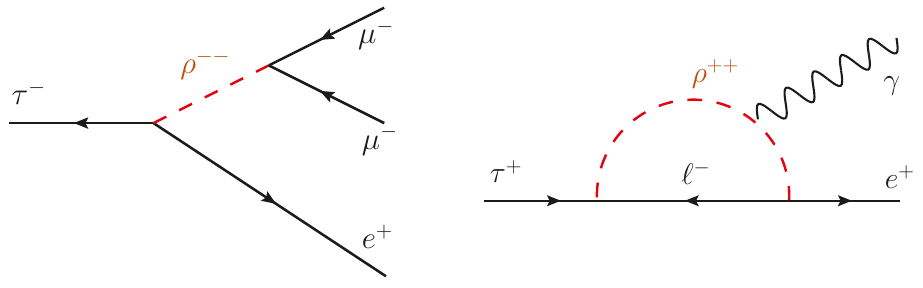
Figure 3 . Feynman diagrams in Class 1 for lepton (cid:13)avour violating processes mediated by (cid:26) (cid:6)(cid:6) at tree-level (Left: (cid:28) (cid:0) e + (cid:22) (cid:0) (cid:22) (cid:0) ) and loop-level (Right: (cid:22) + e + (cid:13) ). ! ! H(cid:31)‘ R (for an SU(2) L doublet (cid:31) ). In addition, this Z 2 symmetry would stabilize the lightest Z 2 -odd particle to provide possible DM particle candidates in these